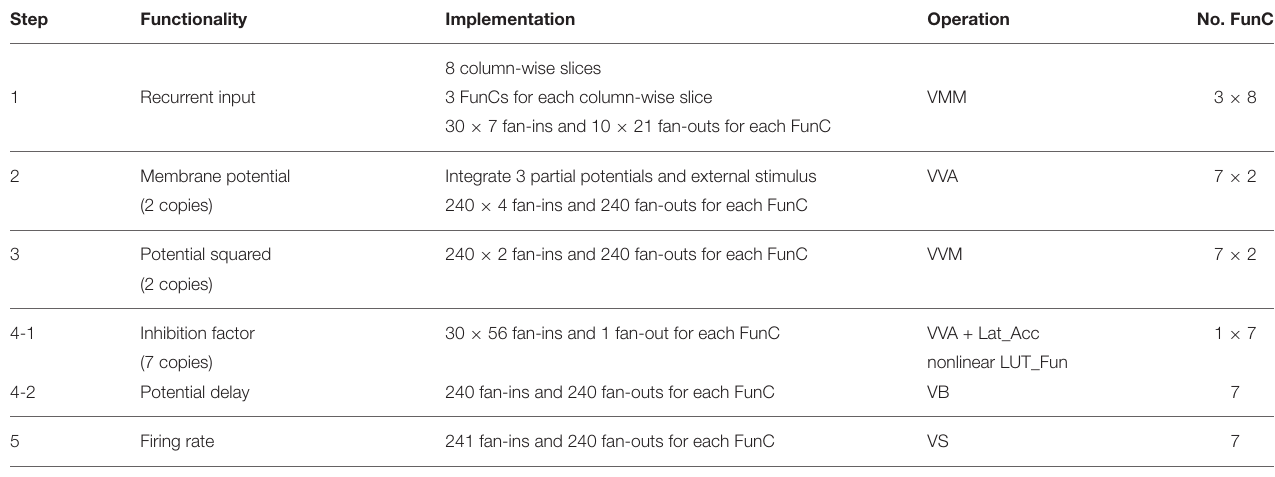
TABLE 5 | Mapping details and resource overhead at every step for a 30 × 56 CANN example.